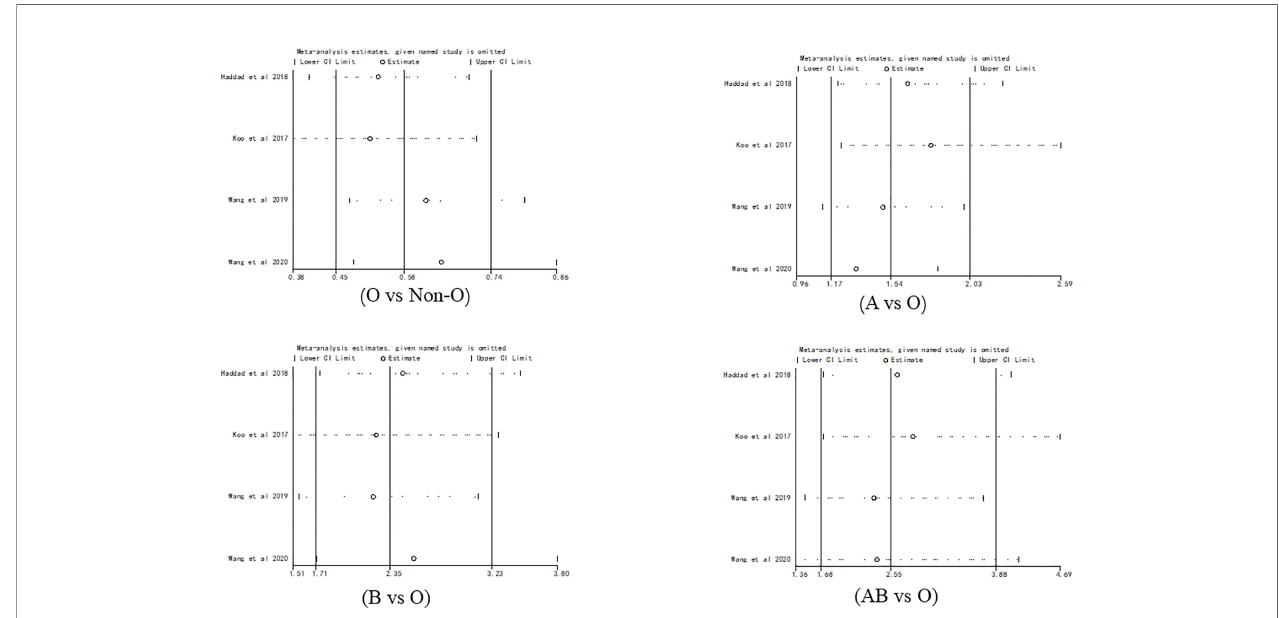
FIGURE 6 | Sensitivity analysis for evaluating the association between PICC-associated VTE and the prevalence of ABO blood